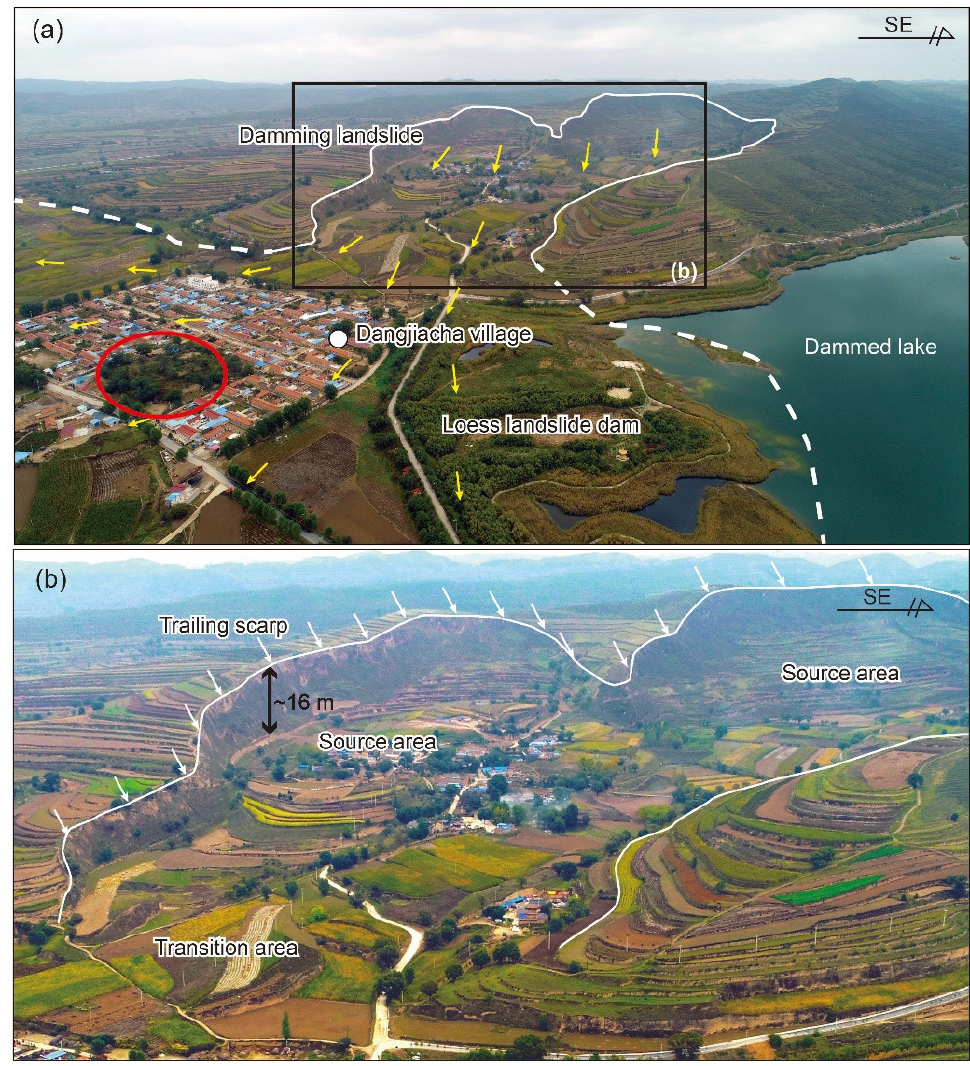
Figure 3. Field photograph of Haiyuan-earthquake-triggered landslide at Dangjiacha village (35.841205°N, 105.462299°E). ( a ) The material loss in the landslide area and the steep trailing scarp are apparent. The position indicated by the red circle shows that the loess landslide dam surface is uneven. ( b ) The detailed UAV photo shows the source area of the Dangjiacha landslides.